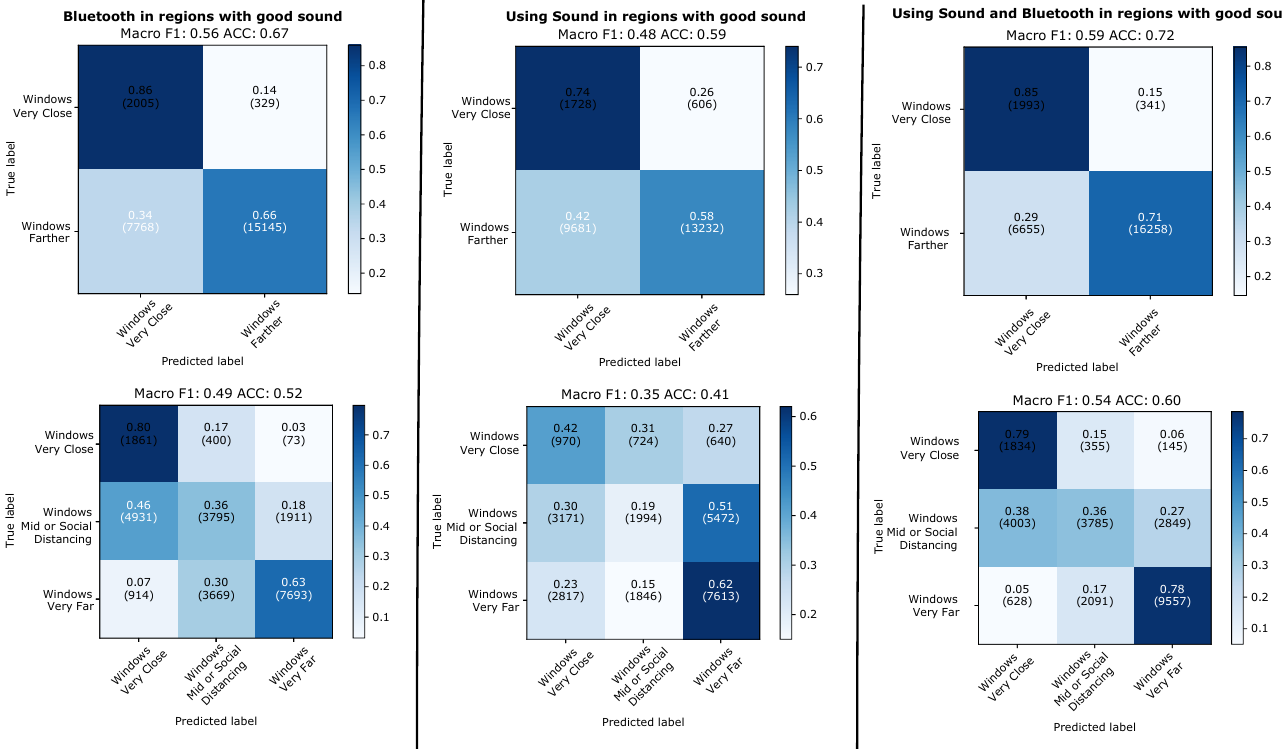
Figure 13. Leaving-one-day-out. Results predicting individual 5 s windows with good sound.